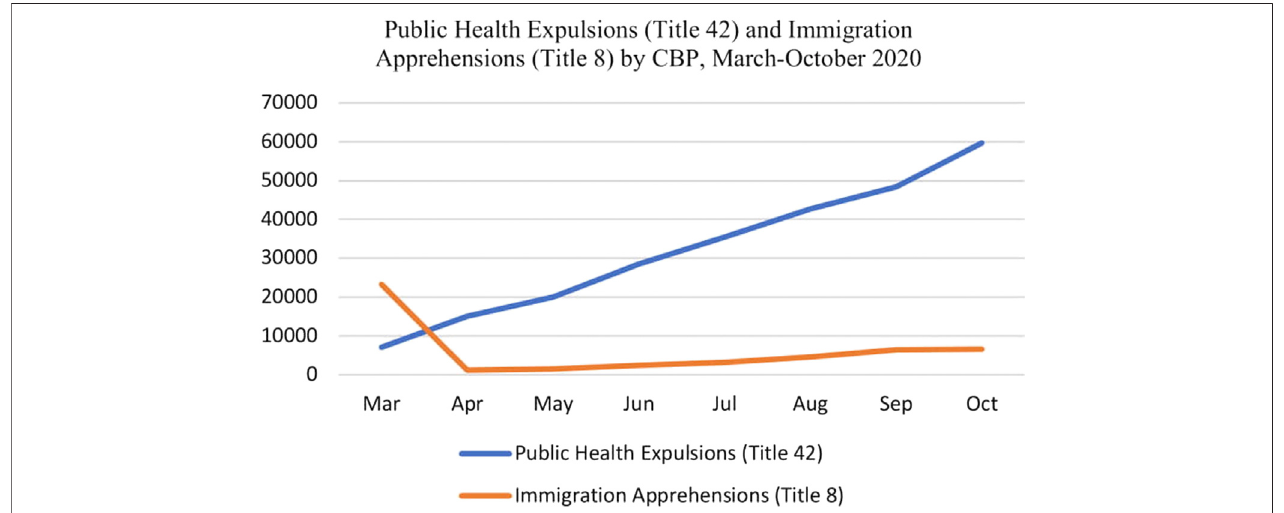
FIGURE3| PublichealthexpulsionsandimmigrationapprehensionsbyCBP,MarchtoOctober2020.Sources:CBP,nationwideenforcementencounters:Title8.